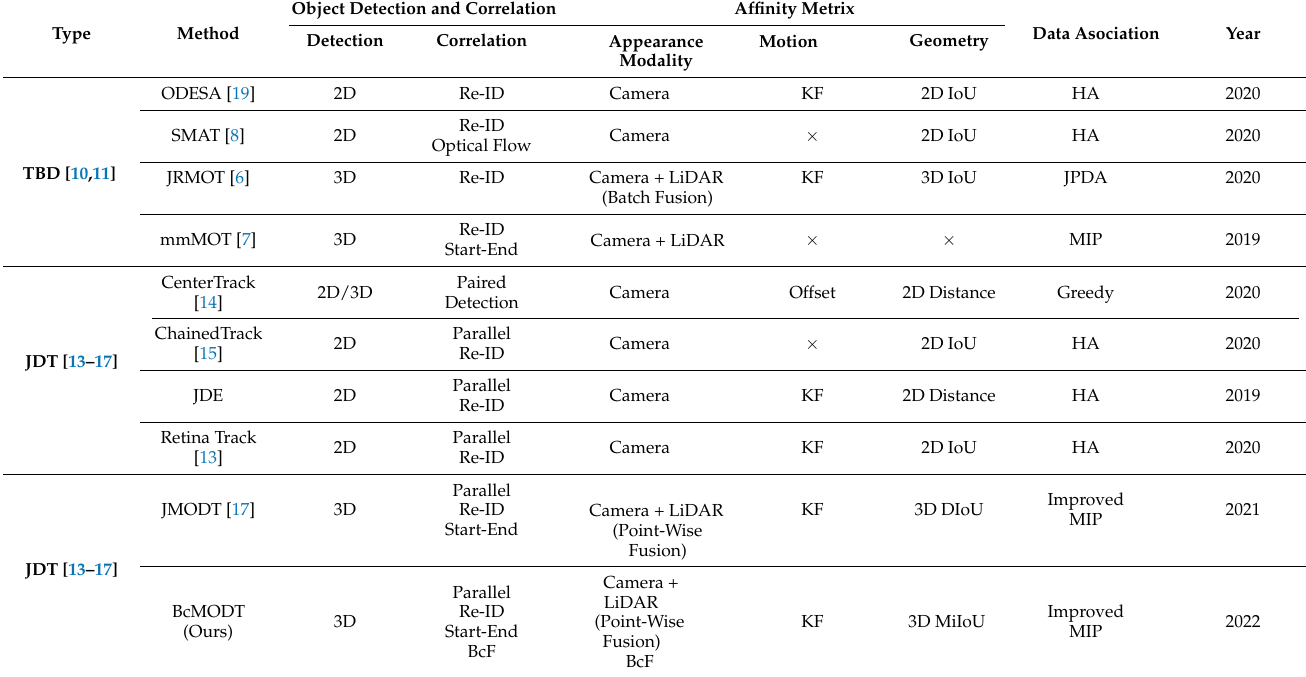
Table 1. A methodological comparison between state-of-the-art MOT and the proposed BcMOT